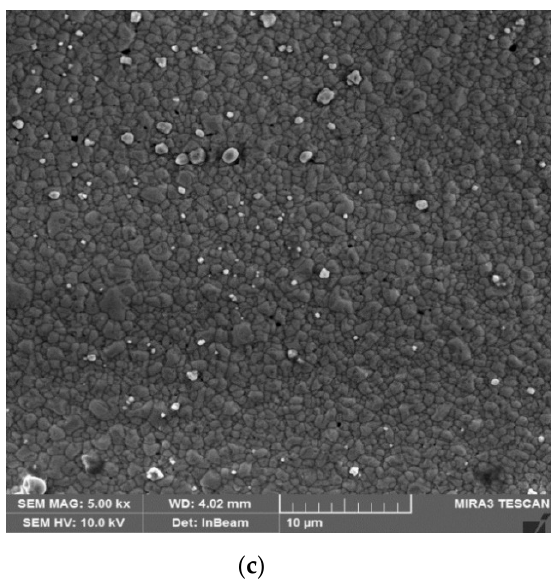
Figure 7. Microstructure of the conductive film at: ( a ) 10.0 kx, ( b ) 25.0 kxc, and ( c ) 5.00 kx.